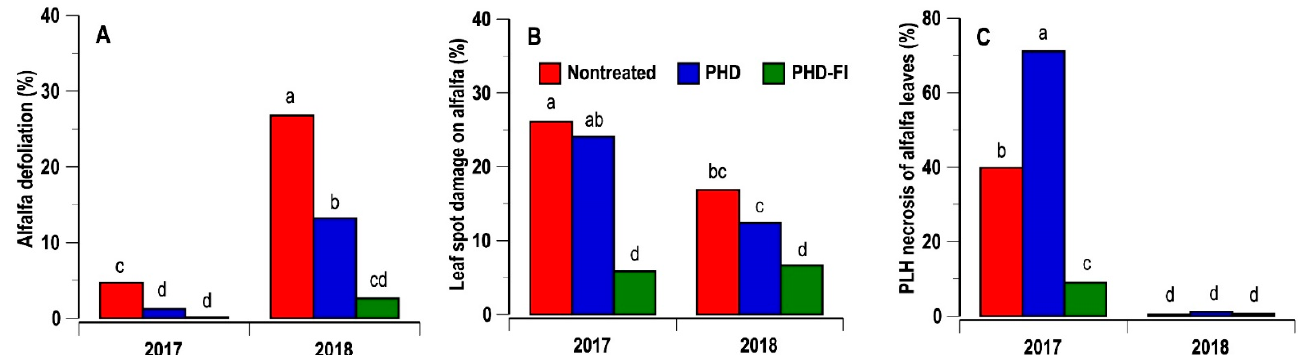
Figure 3. Production year and agrichemical treatment impacts on alfalfa defoliation ( A ) and damage of remaining leaves by common leaf spot ( B ) and potato leafhopper (PLH, C ). Agrichemical treatments applied to alfalfa during establishment included a nontreated control, prohexadione (PHD), and prohexadione followed by fungicide and insecticide (PHD-FI). Data were collected two weeks after application of fungicide and insecticide and were averaged across alfalfa varieties and corn populations. Least square means with no common letter are significantly different ( p = 0.05).